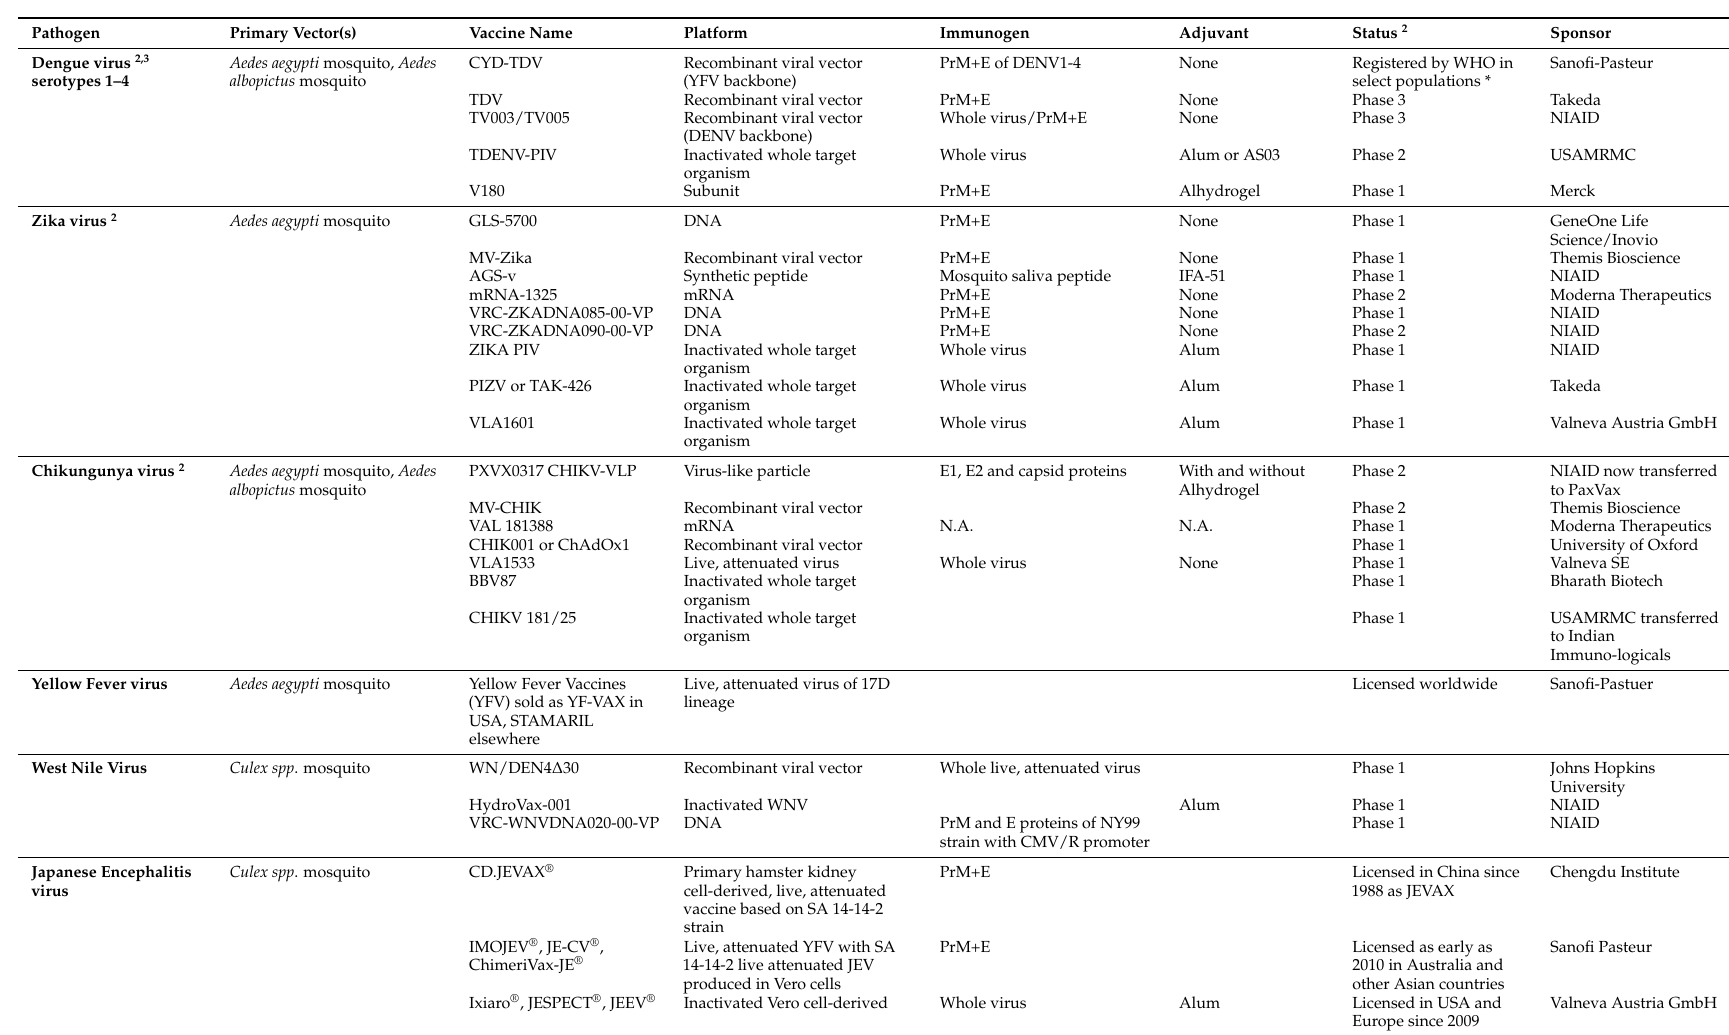
Table 1. Status of arthropod vector-borne disease vaccines licensed or in clinical trials 1